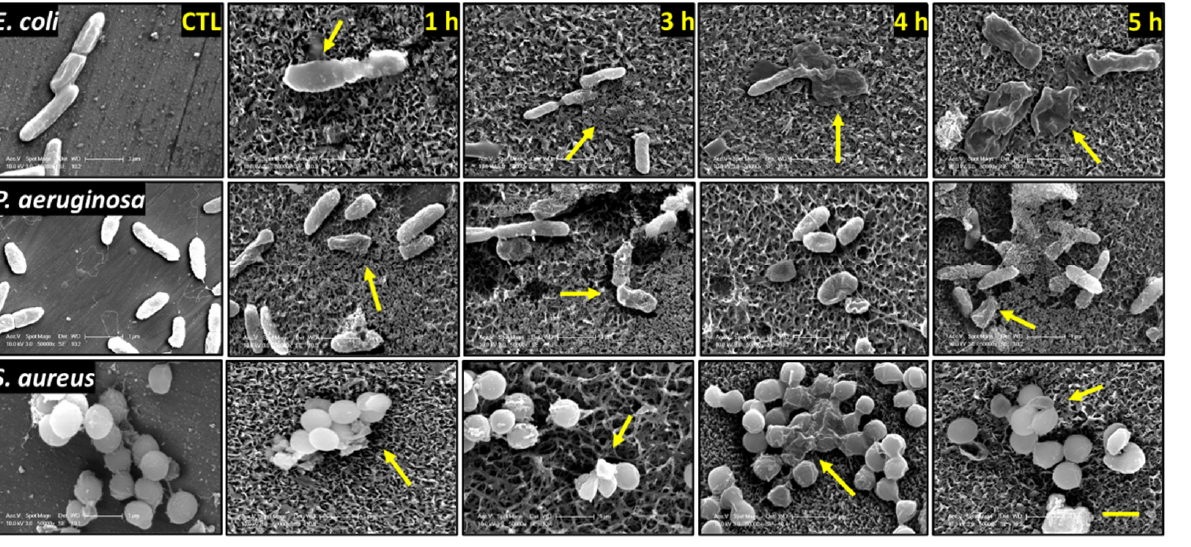
Figure 4. SEM micrographs of E. coli , P. aeruginosa , and S. aureus following 20 h incubation on the KOH-etched samples (1, 3, 4, and 5 h etching time). Yellow arrows indicate damaged bacteria. SEM images were acquired at 50,000 magnification. Scale bar bottom right image represents 1 µm.